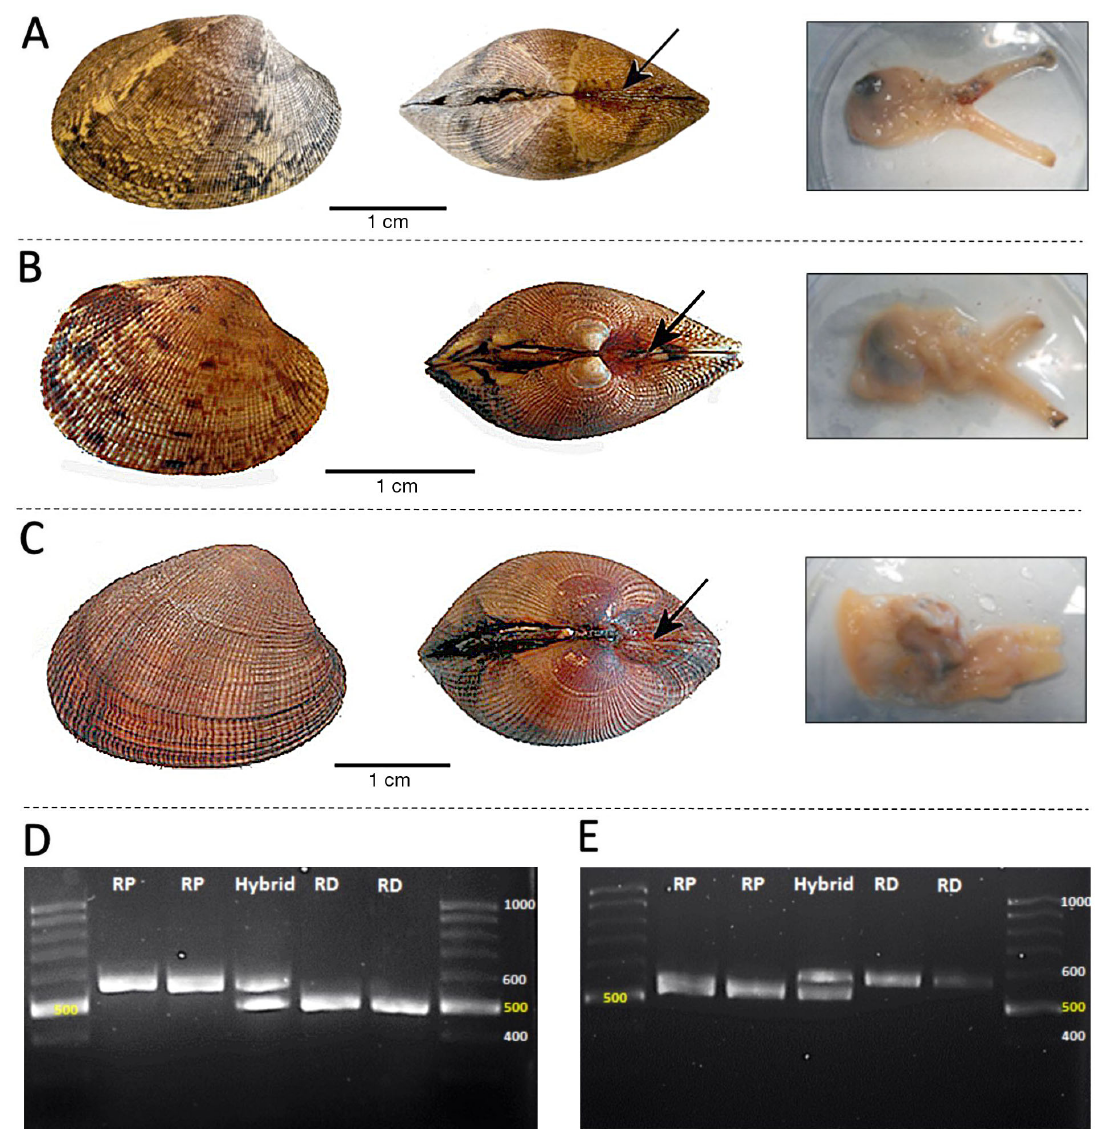
Fig. 3. Morphological features of shells of Ruditapes spp.; lunules are indicated with arrows (more apparent defined heart shape at the bottom for R. philippinarum ). Complete mollusk bodies show the siphon characteristics. Genetic assessments for nuclear markers of the sampled Ruditapes sp. in this work are also shown. (A) Post-F1 hybrid detected using nuclear genetic markers but with R. decussatus morphology. (B) Individual showing diagnostic characters of both R. philippinarum and R. decussatus . (C) R. philippinarum morphology. (D) Amplified PCR products from ITS2 nuclear genetic markers showing characteristic bands from R. decussatus (RD, 482 bp), R. philippinarum (RP, 565 bp), and hybrids. (E) Amplified PCR products from 5SrDNA nuclear genetic markers showing characteristic bands from R. decussatus (593 bp), R. philippinarum (526 bp), and